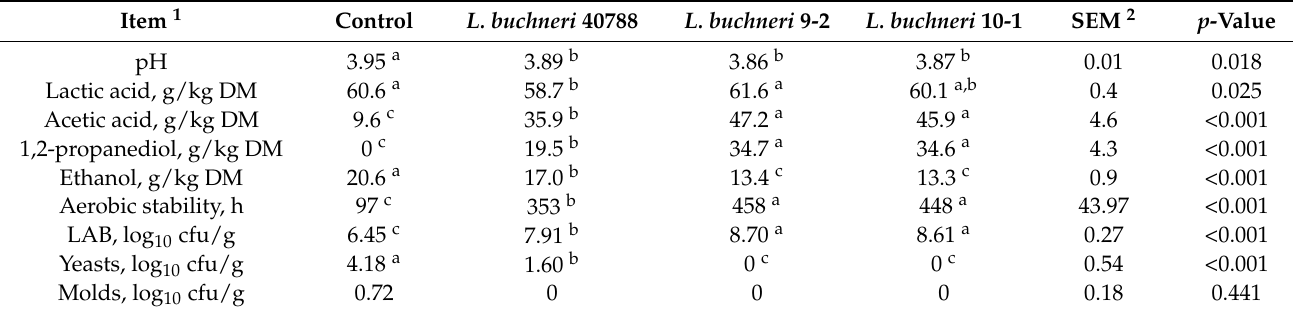
Table 5. Fermentation quality (g/kg DM basis), aerobic stability and microbial content (wet basis) of corn silage after 90 d of ensiling